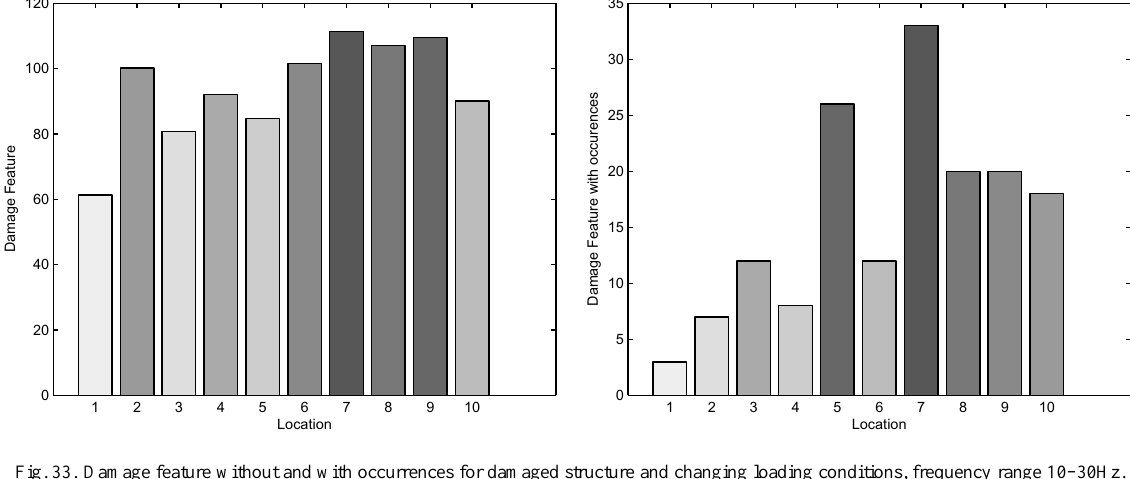
Fig. 33. Damage feature without and with occurrences for damaged structure and changing loading conditions, frequency range